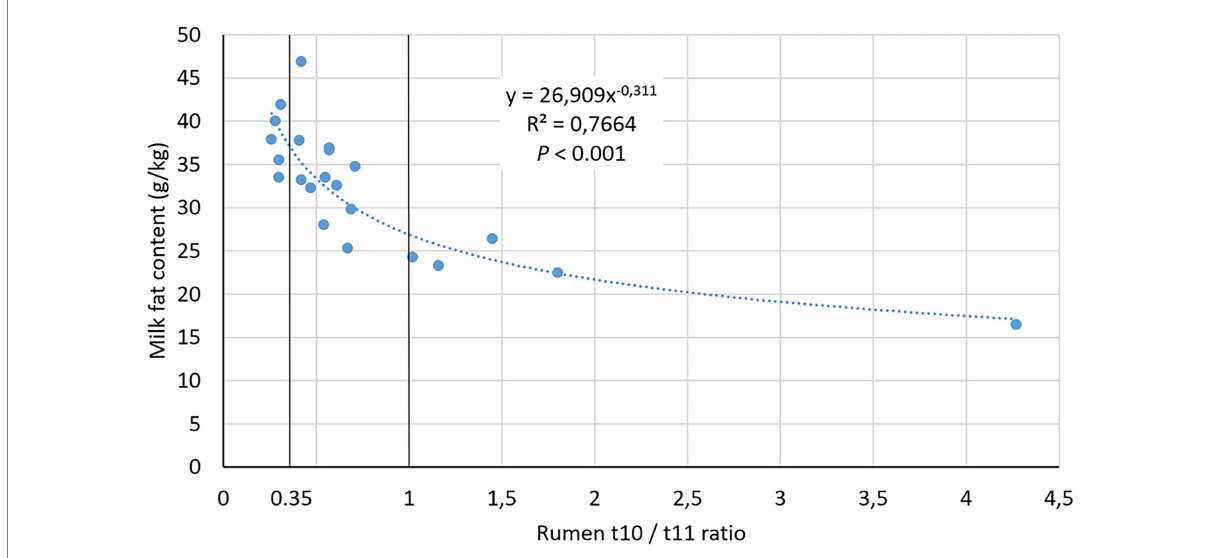
FIGURE 1 Relationship between rumen trans -10/ trans -11 ratio and milk fat content in the field study.